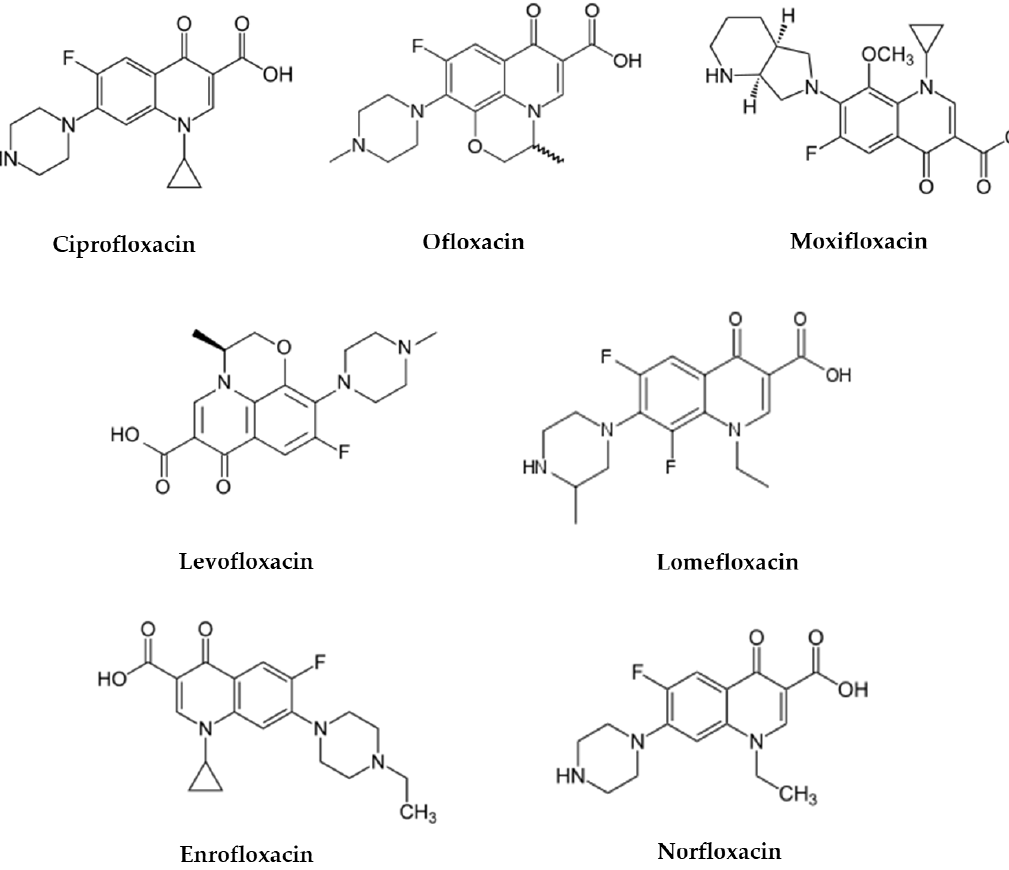
Figure 2. Chemical structures of the most investigated fluoroquinolones.